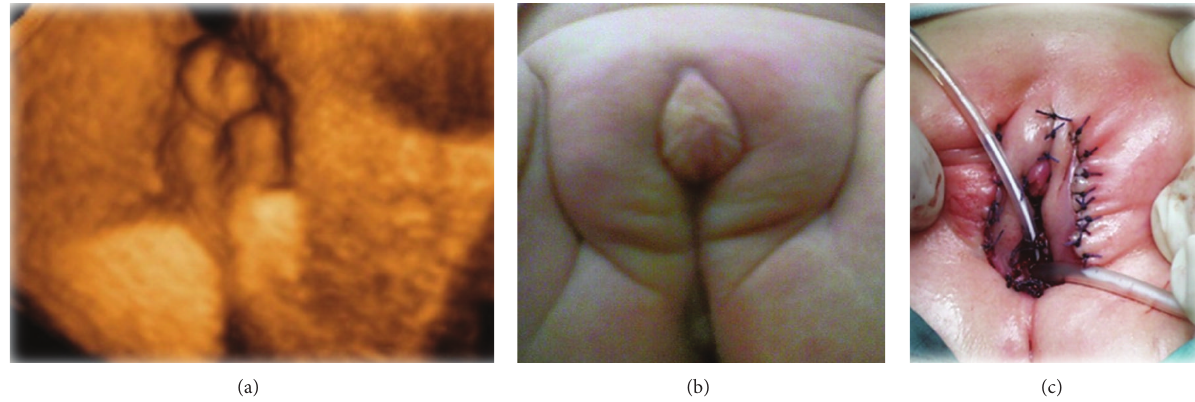
Figure 1: (a) 4D surface rendering female/ambiguous external genitalia; (b) female genitals with oedematous labia majora and mild clitoromegaly; (c) perineal vulvovaginoplasty, clitoroplasty, and